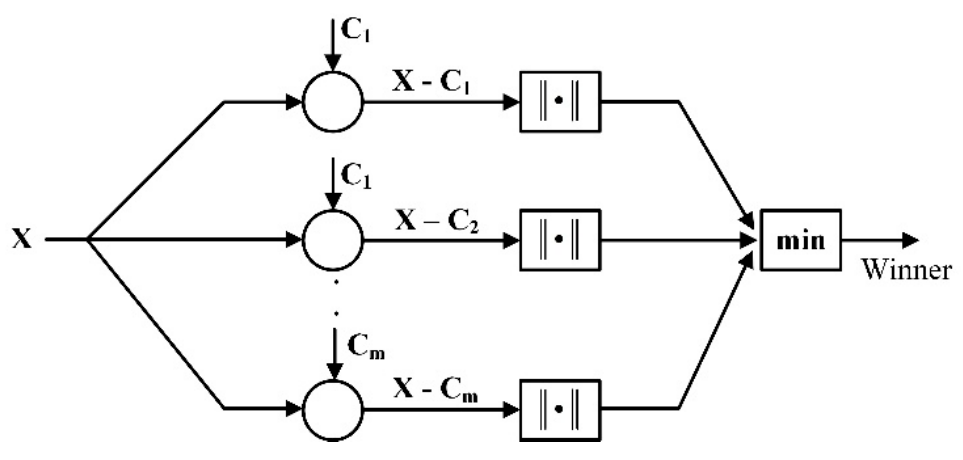
Figure 2. K-means algorithm.